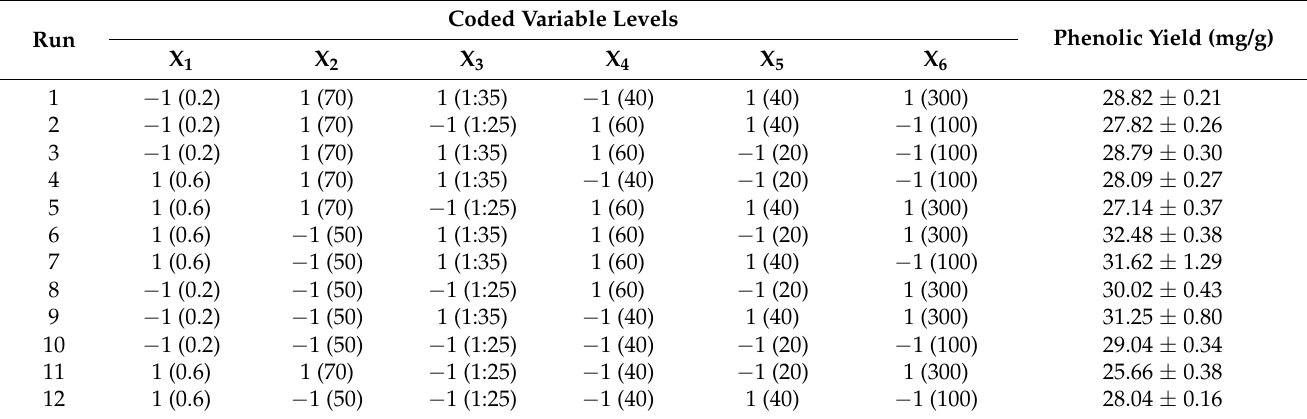
Table 1. Plackett–Burman experimental design and results.